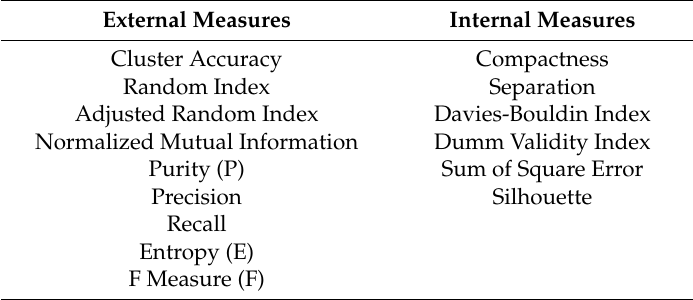
Table 2. Internal and External measures for evaluation of clustering algorithm